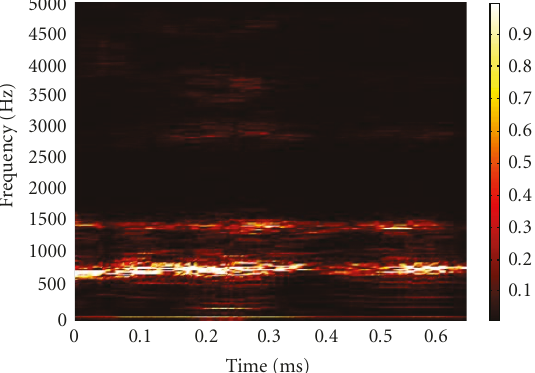
Figure 6: Vocal signal frequency versus time